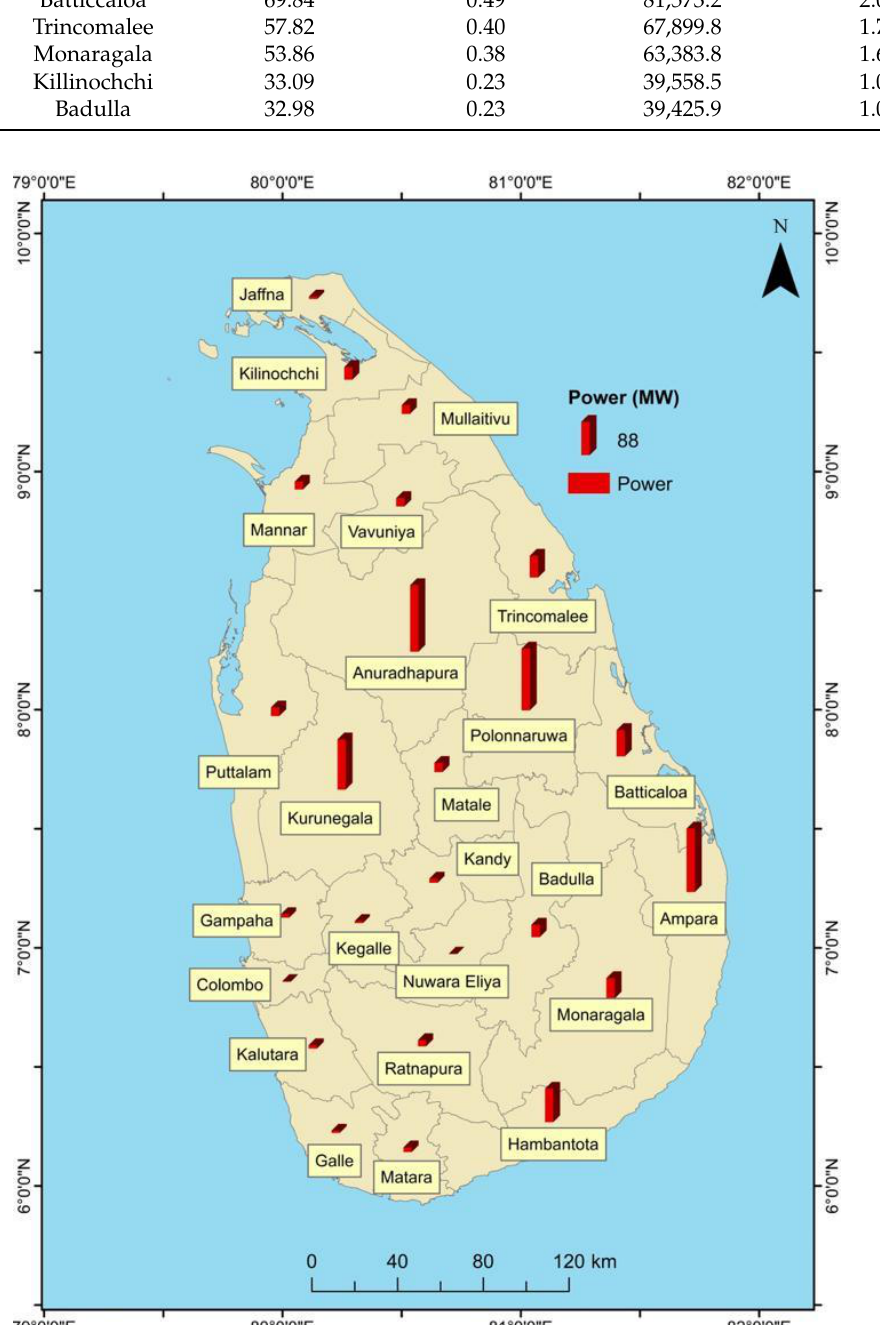
Figure 8. Power plant distribution. Table 4. Location, electrical power, electricity generation, NPV , and PI of GFC/ST plants with a pos- itive NPV .